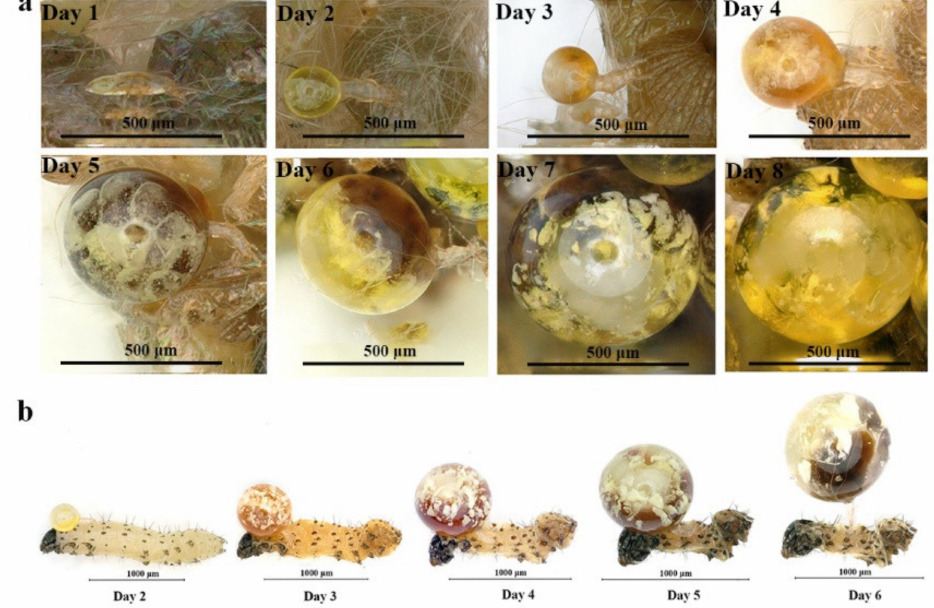
Figure 1. Opisthosoma development in individual Pyemotes zhonghuajia females on ( a ) eggs and ( b ) first instar larvae of Spodoptera litura